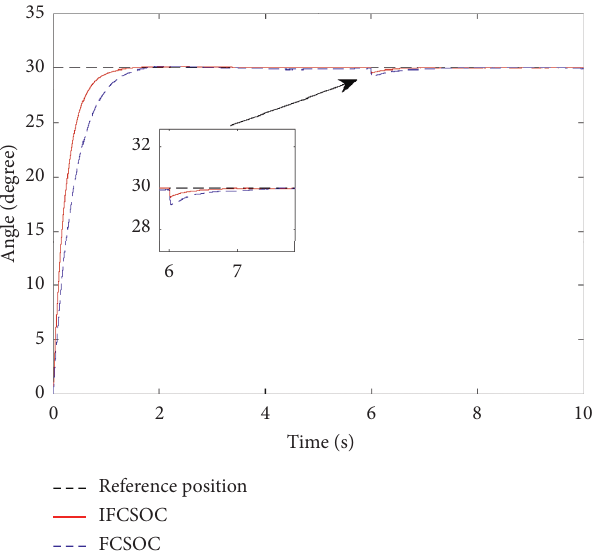
Figure 4: Step simulation with load step disturbance.